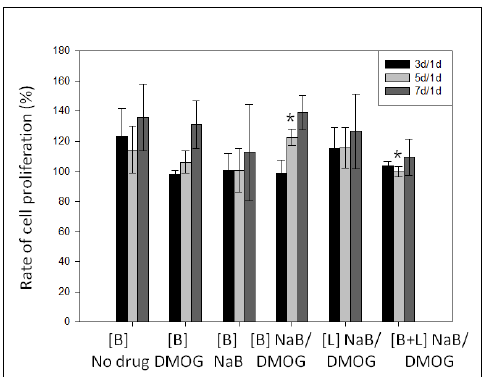
Figure 12. Cell proliferation of MC3T3 cells on the patterned HA gel during cluster formation,